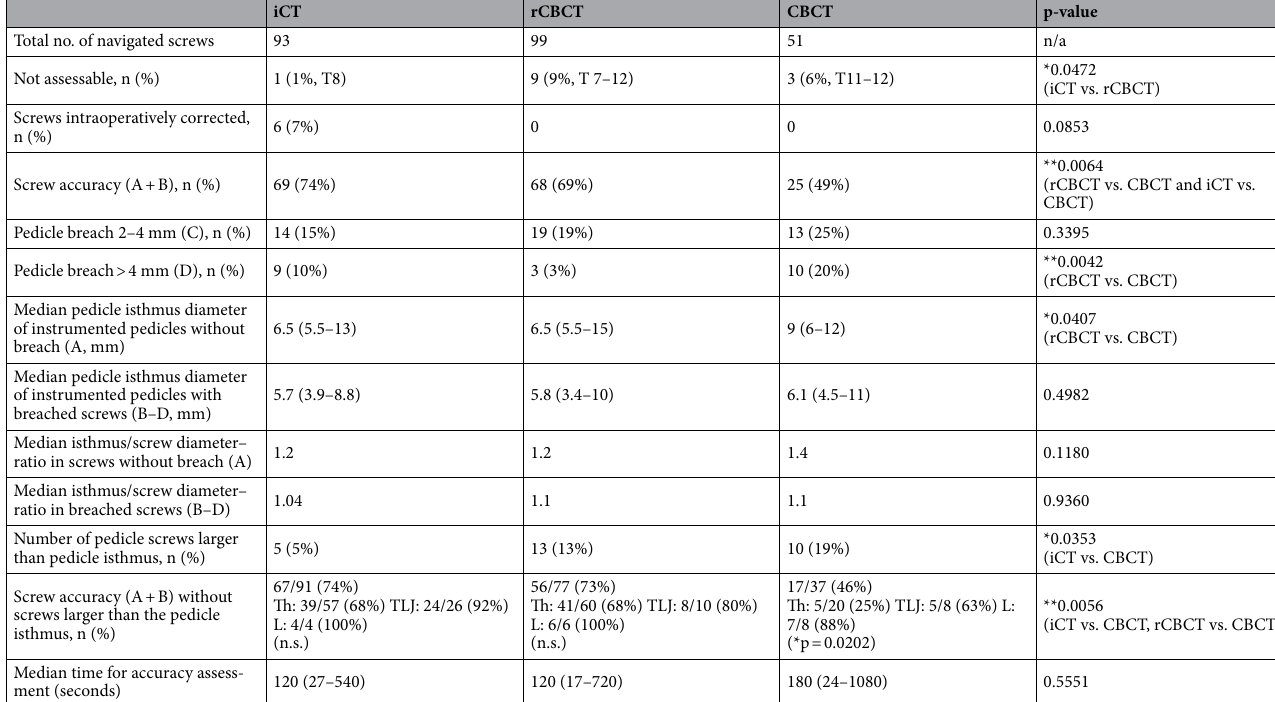
Table 3. CFRP screw accuracy and assessability depending on imaging modality. Values are given in total number with percentage or as median with total range, as appropriate. iCT Intraoperative CT, rCBCT robotic cone beam CT, CBCT cone beam CT, n.s. not statistically significant. Based on SIN score: L = lumbar (L2-5), Th = thoracic (Th1-10), TLJ = thoraco-lumbar junction